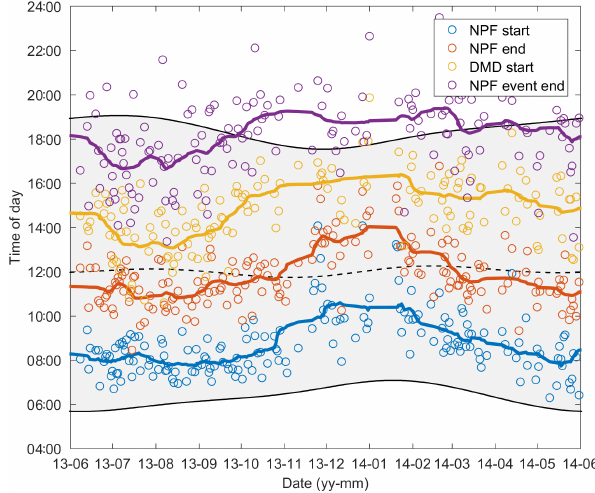
Figure 7. Seasonal variation of the different phases of the NPF events observed in Hada Al Sham. The colored lines show the 20- point moving average for each of the different phases. The solid black lines show the times of sunrise and sunset, while the dashed black line shows the time of maximum solar radiation calculated based on the latitude of the measurement